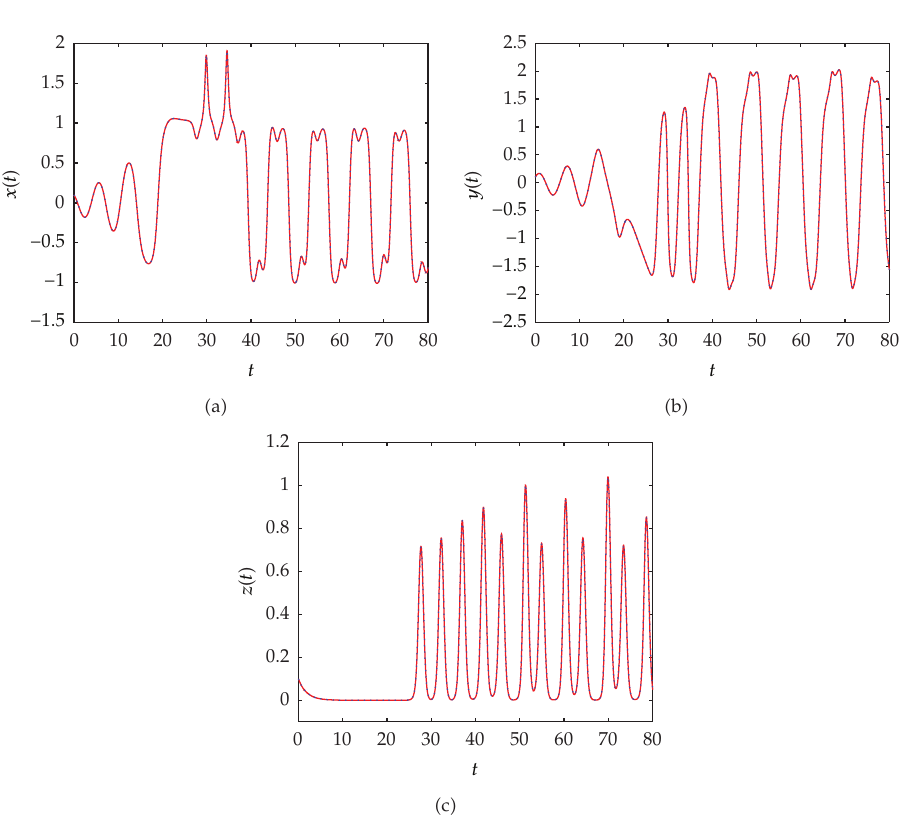
Figure 9: Comparison between the MSRM (cid:2) solid line (cid:3) and ode45 (cid:2) dots (cid:3) results for the Rabinovich- Fabrikant system for a (cid:9) 0 . 1 and b (cid:9) 0 . 2715.